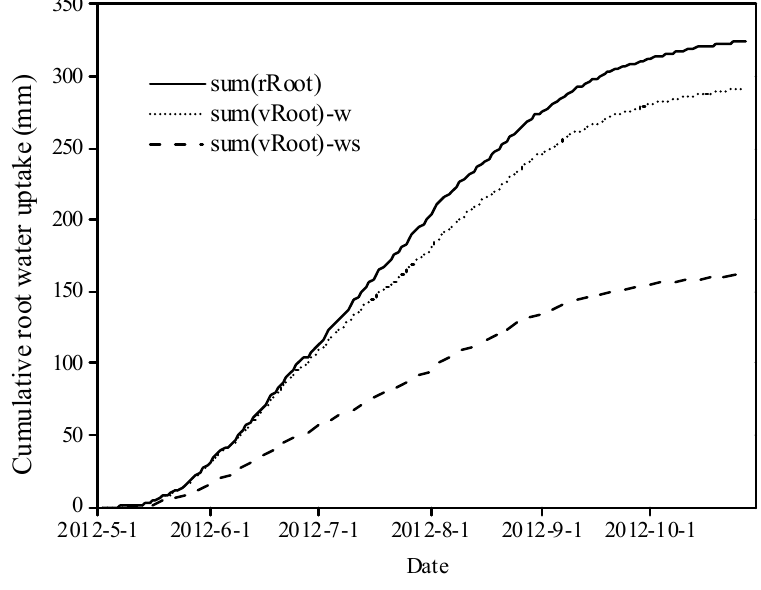
Figure 5. Cumulative root water uptake under different stress conditions. Note: sum(rRoot), potential cumulative root water uptake; sum(vRoot)-w, cumulative root